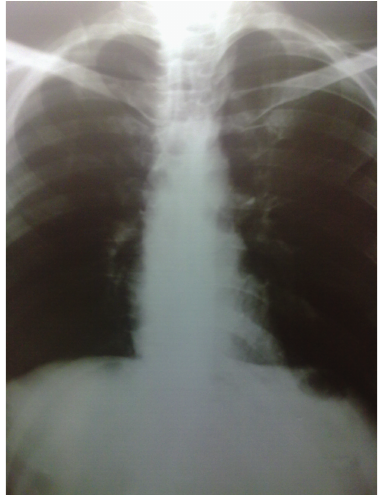
Figure 4: Chest X-ray.